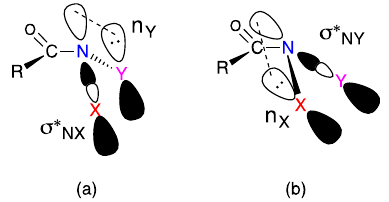
Figure 8. Two possible anomeric interactions in anomeric amides ( a ) n Y – σ * NX and ( b ) n X – σ * NY .